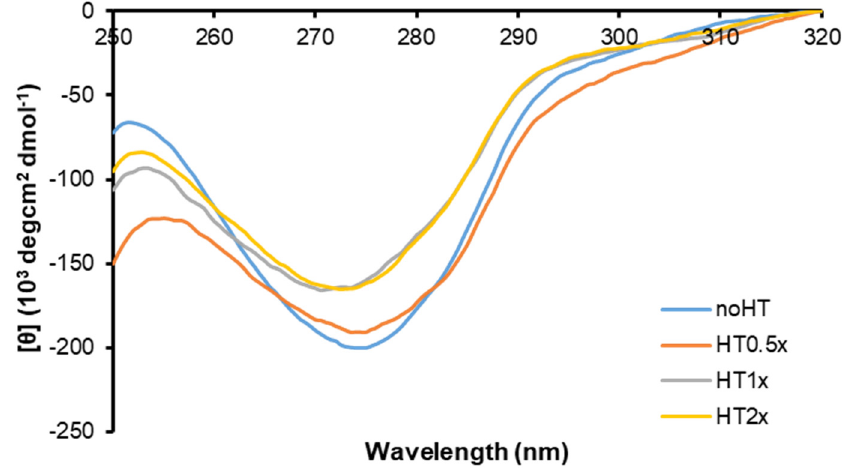
Figure 5. E ff ect of HT on insulin oligomerization state monitored by near-UV CD spectroscopy. Near-UV CD spectra of insulin in the absence and in the presence of HT in a 0.5, 1, and 2 × molar ratio. Protein concentration was 2.0 mg / mL, other experimental details are described in the Methods section.